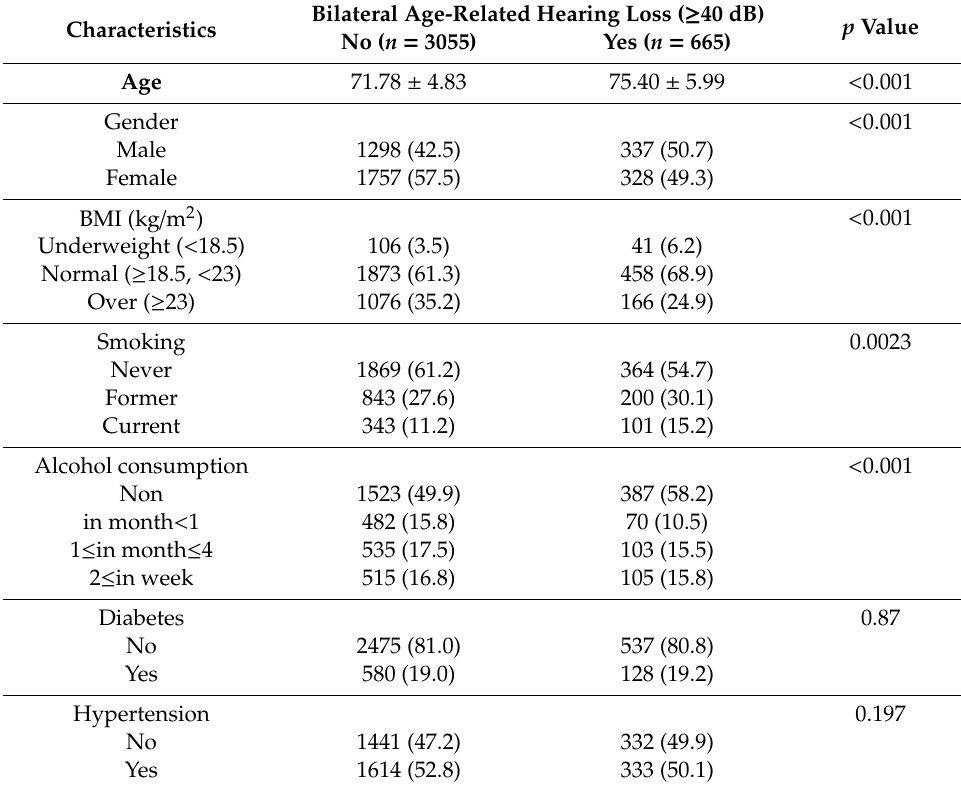
Table 1. Baseline characteristics of study